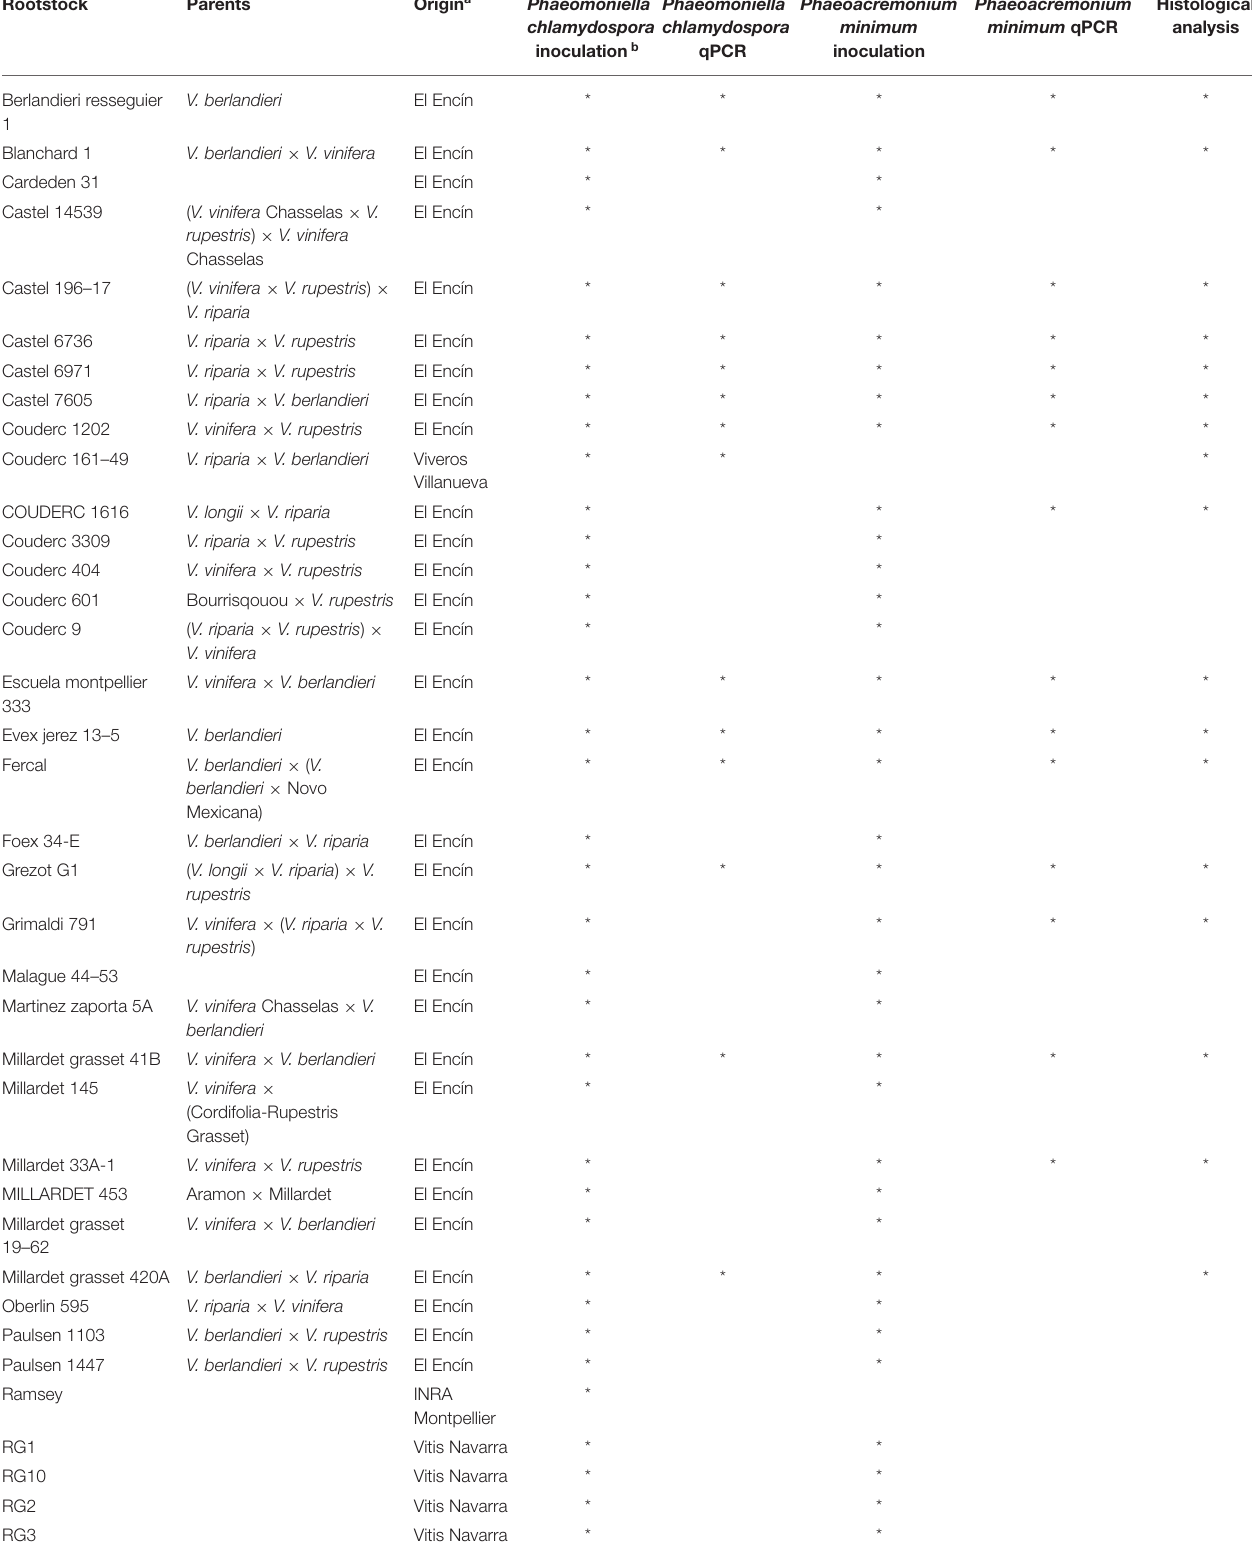
TABLE 1 | List of the rootstocks used in the study.